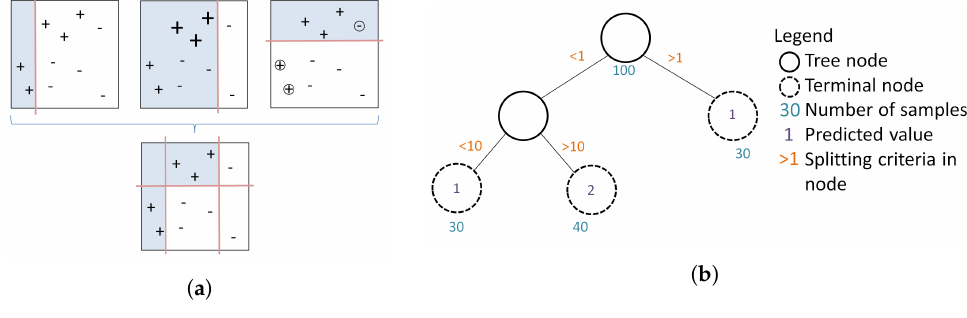
Figure 8. ( a ) shows the combination of weak learners to one strong prediction rule used in the BRT ensemble approach and ( b ) illustrated the hierarchical regression and binary splitting process along the branches of the decision tree. ( a ) Binary splits indicated as red straight lines separate the data in grey and white sections and create weak learners as seen in Equation (1). BRT as an ensemble approach combines them to create complex prediction rules. Adapted from [46]. ( b ) Hierarchical regression and binary splitting process showing observations in the nodes, predicted values in the terminal nodes and splitting criteria along the tree